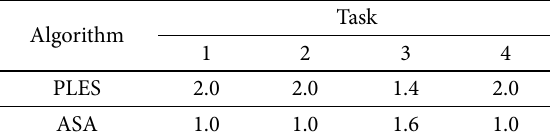
Table 19. Average rankings of the algorithms